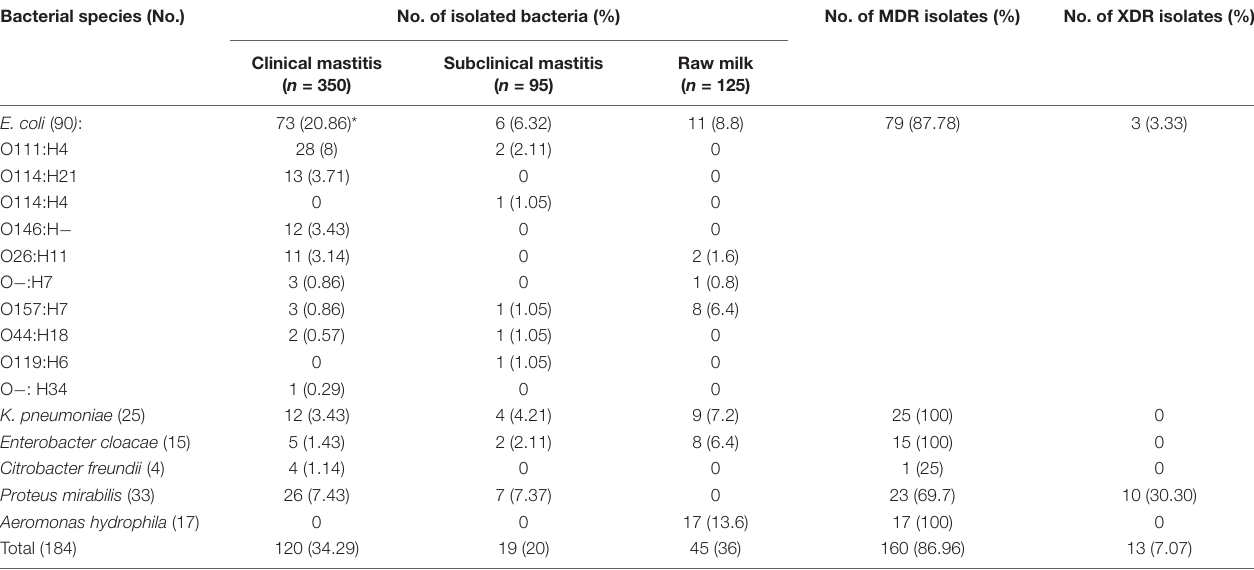
TABLE 1 | Prevalence of Gram-negative bacteria isolated from clinical, subclinical bovine mastitis, and raw milk in Egypt. Bacterial species